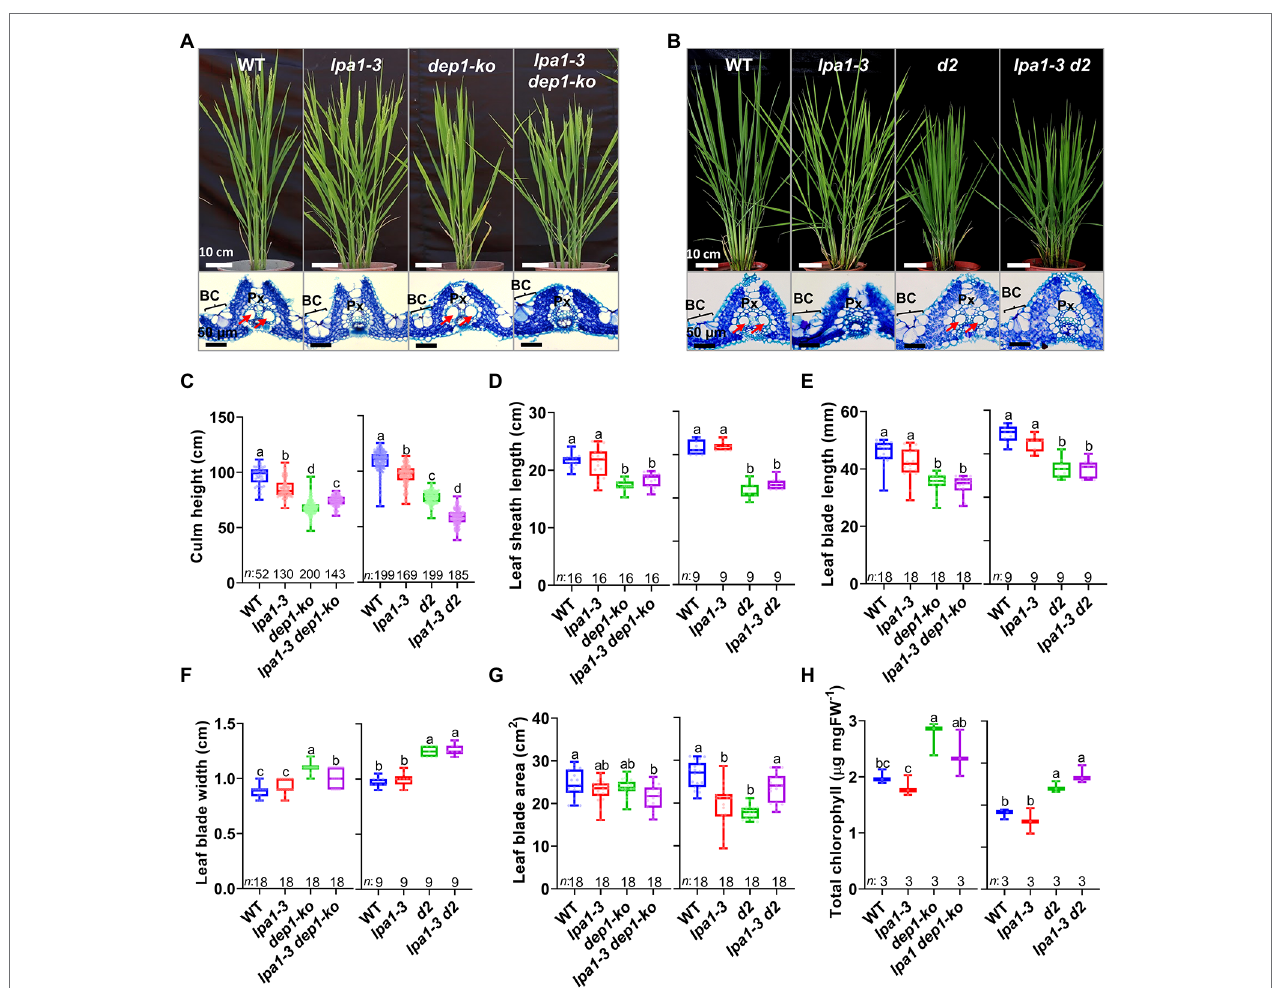
FIGURE 5 | Field phenotypes, cross sections of vascular bundles, and morphological characteristics of lpa1-3 dep1-ko and lpa1-3 d2 . (A,B) Representative plant growth and vascular bundles of WT, lpa1-3, dep1-ko, lpa1-3 dep1-ko (A) , and WT, lpa1-3, d2, lpa1-3 d2 (B) . The lower section of the figures shows the cross sections of the leaf blades. Red arrows indicate the normally enlarged metaxylem vessels; BC, bulliform cells; Px, protoxylem. (C–G) Quantification and comparison of morphological characteristics which are culm height (C) , leaf sheath length (D) , leaf blade length (E) , leaf blade width (F) , and leaf blade area (G) among WT, lpa1-3, dep1-ko, lpa1-3 dep1-ko (left) and WT , lpa1-3, d2, lpa1-3 d2 (right). (H) Quantification and comparison of total chlorophyll content in mature leaves among the eight genotypes. All the genotypes are BC2F3 generation which are the progenies of segregation after backcrossing three times. For each box plot, the lower and upper bounds of the box indicate the first (Q1) and third (Q3) quartiles, respectively, the center line indicates the median. The different letters denote significant differences between samples by one-way ANOVA followed by Tukey’s post-hoc test ( p < 0.05). n , number of replicates. Scale bars are indicated in each